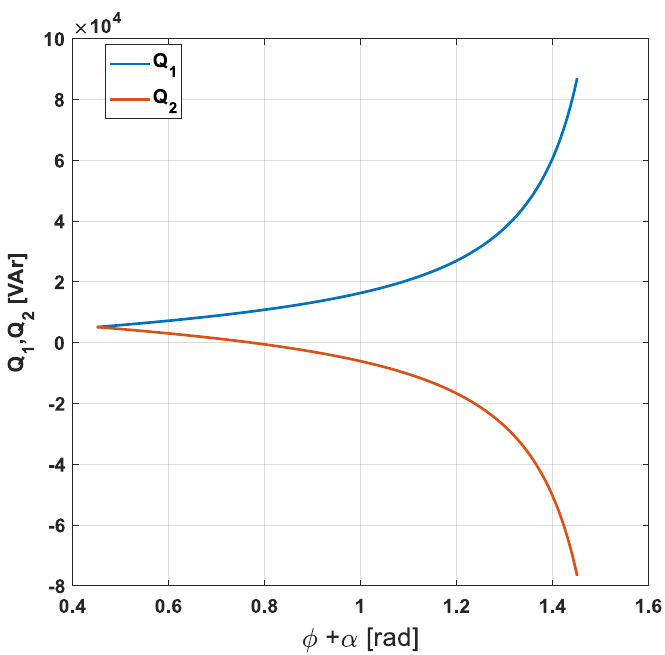
Figure 8. The dependence of the reactive power of generators Q 1 and Q 2 on the angle φ + α .